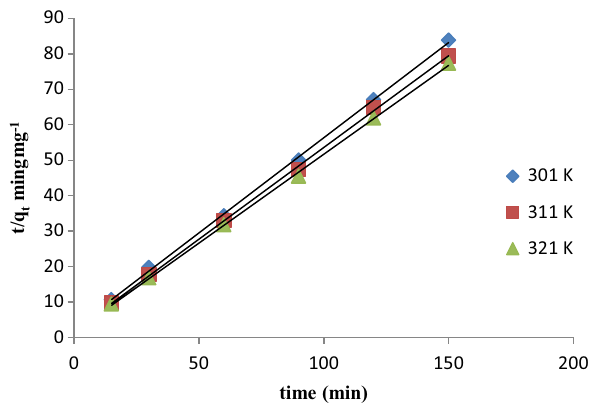
Fig. 8 Pseudo-second-order kinetic plots for adsorption of CR dye on MSC at different temperatures